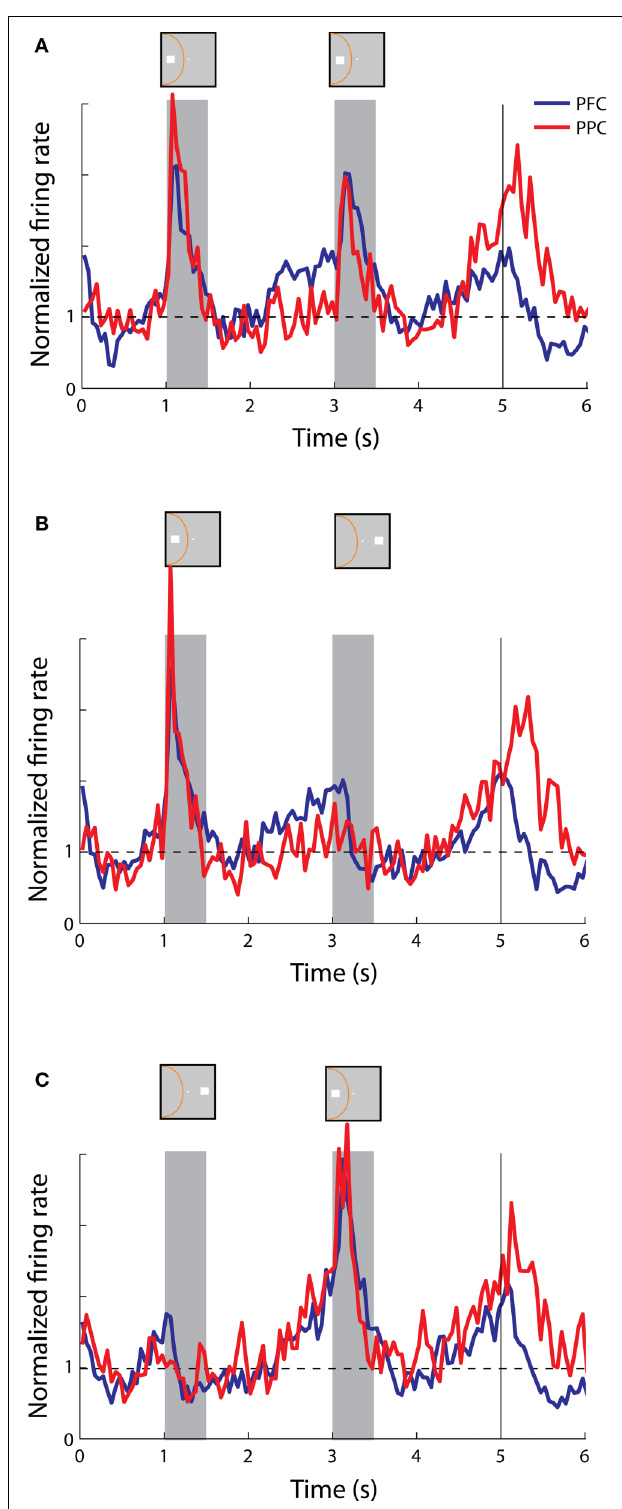
FIGURE 8 | Population responses from neurons with anticipatory activity recorded in the prefrontal ( N = 25) and posterior parietal cortex ( N = 19). (A,B,C) Average, normalized responses to the cue followed by a stimulus in the receptive fi eld (A,C) or out of the receptive fi eld (B) , as in Figure